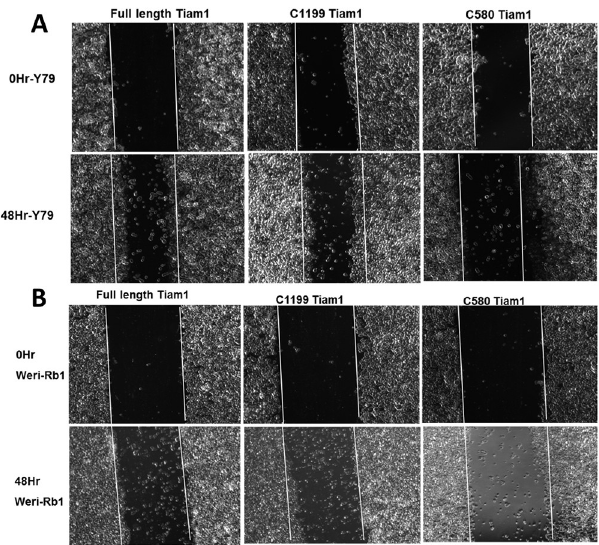
Fig 8. N-terminal PH domain maintains cell motility in retinoblastoma cells. Phase contrast images showing the migration of Y79 and Weri-Rb1 cells transfected with Full length Tiam1, C1199 Tiam1 and C580 Tiam1 in wound- healing assay. White line indicates the original wound edge which made by a pipette tip. The images were taken from 10 different locations. Cells transfected with full length and C1199 Tiam1 showing significant increase in cell migration rate compared to the cells transfected with C580 Tiam1. The Images were captured at 5 × objective in AxioObserver